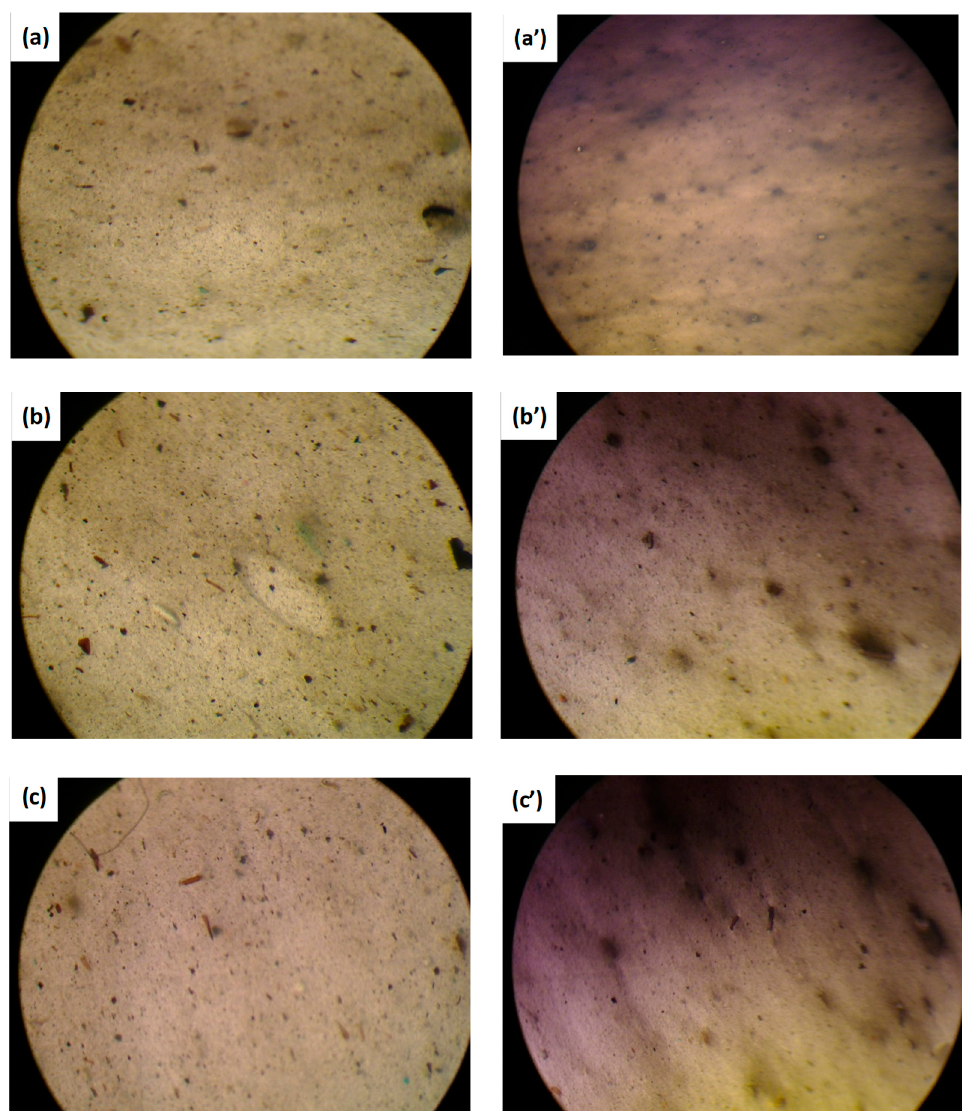
Figure 10. Images of the produced films (on the left Fil-s A-based systems and on the right Fil-s B-based systems) captured with an optical microscope at 8 × magnification: ( a , a’ ) Fil-s + 5%PE/PP-g- MA; ( b , b’ ) Fil-s + 5%D67G; ( c , c’ ) Fil-s + 5%PE/PP-g-MA +